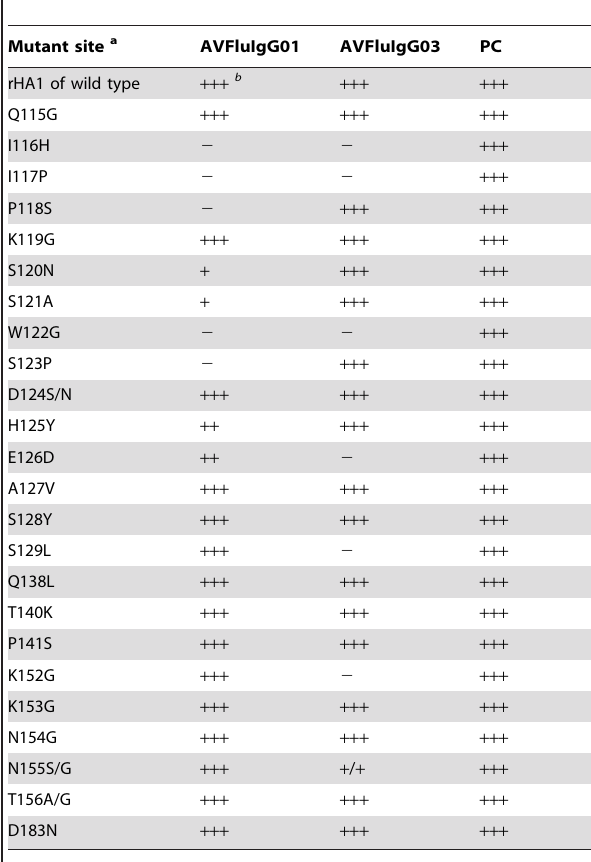
Table 6. Epitope mapping of rhAbs to a panel of site